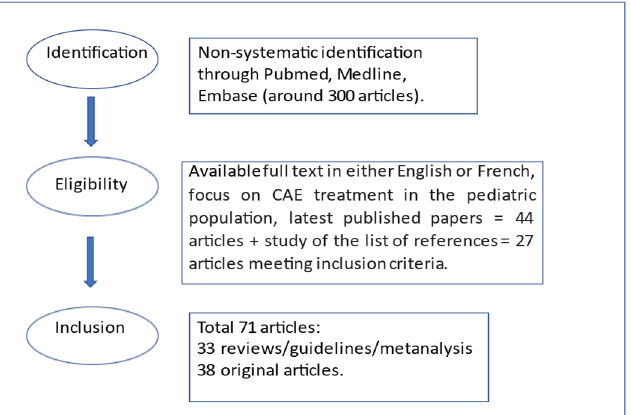
Figure 1. Selection of studies flowchart.